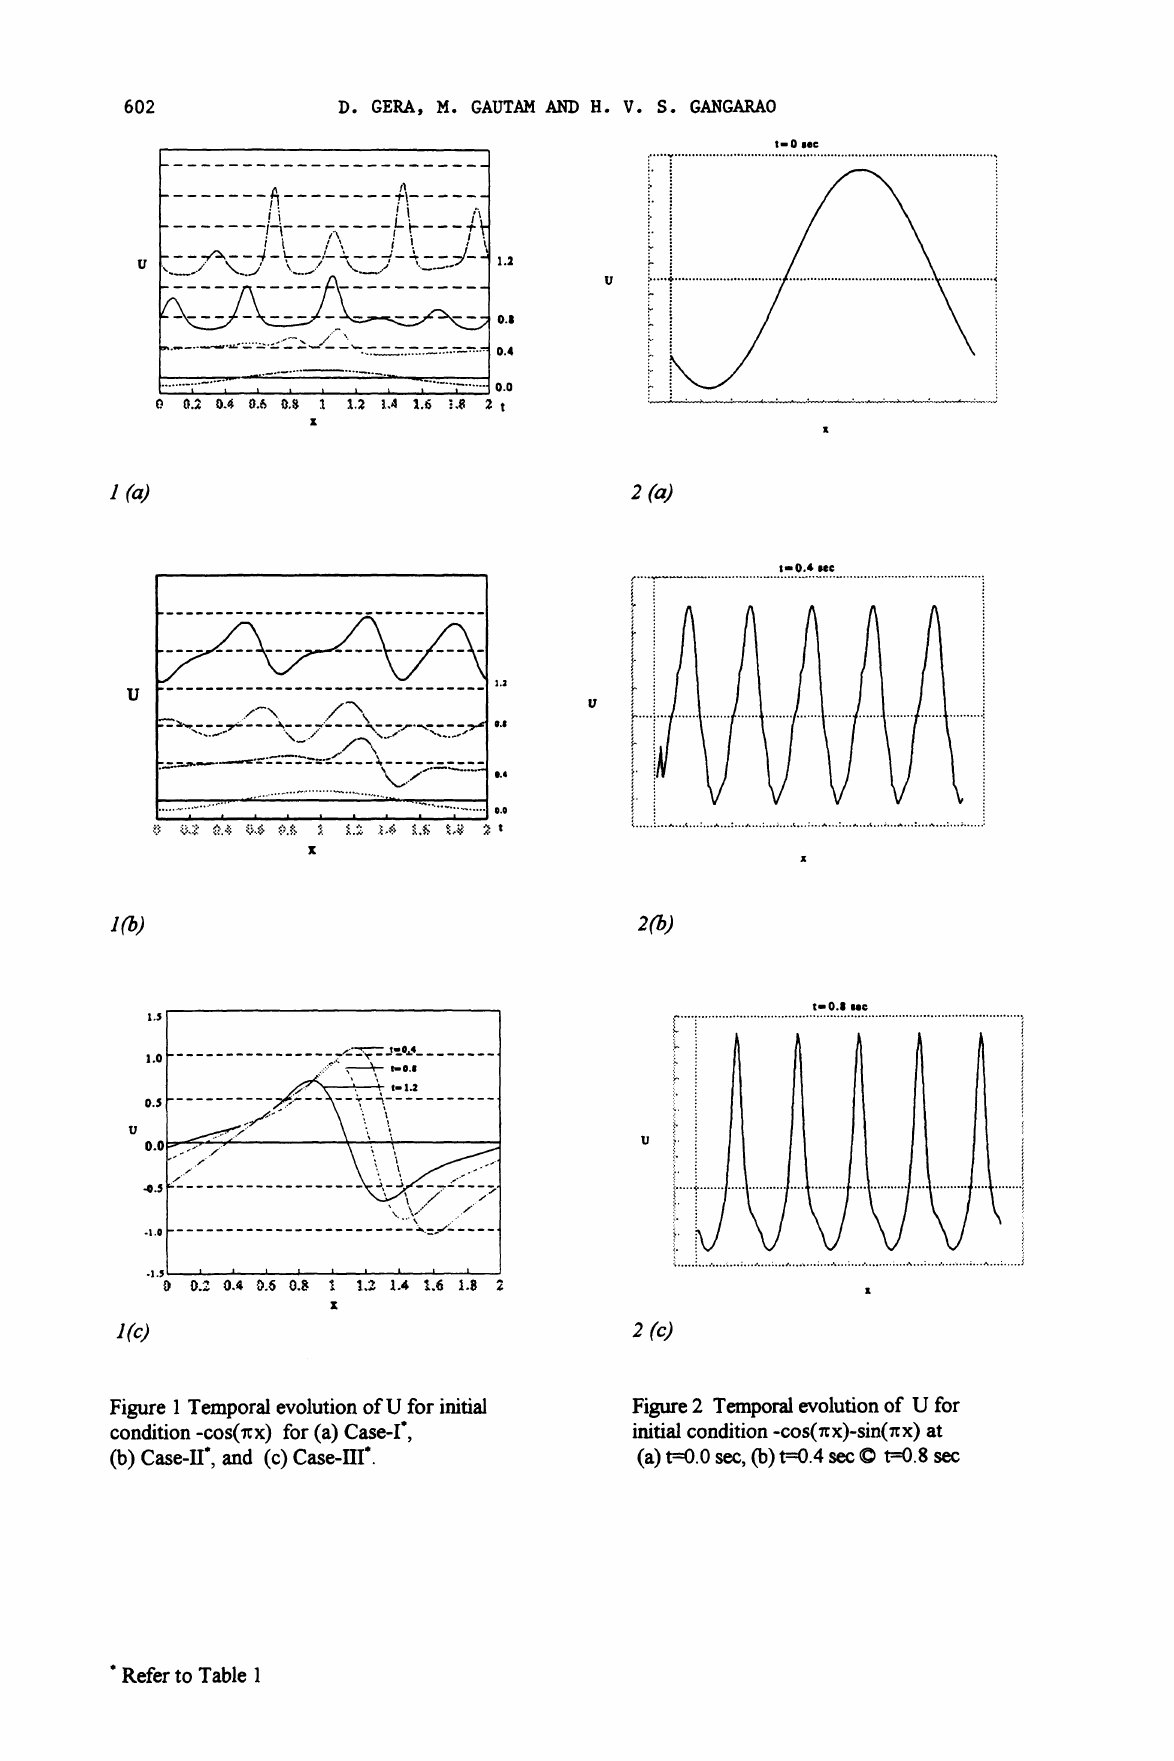
Figure Temporal evolution of U for initial condition -cos(x) for (a) Case-I’, (b) Case-H*, and (c) Case-HI*.